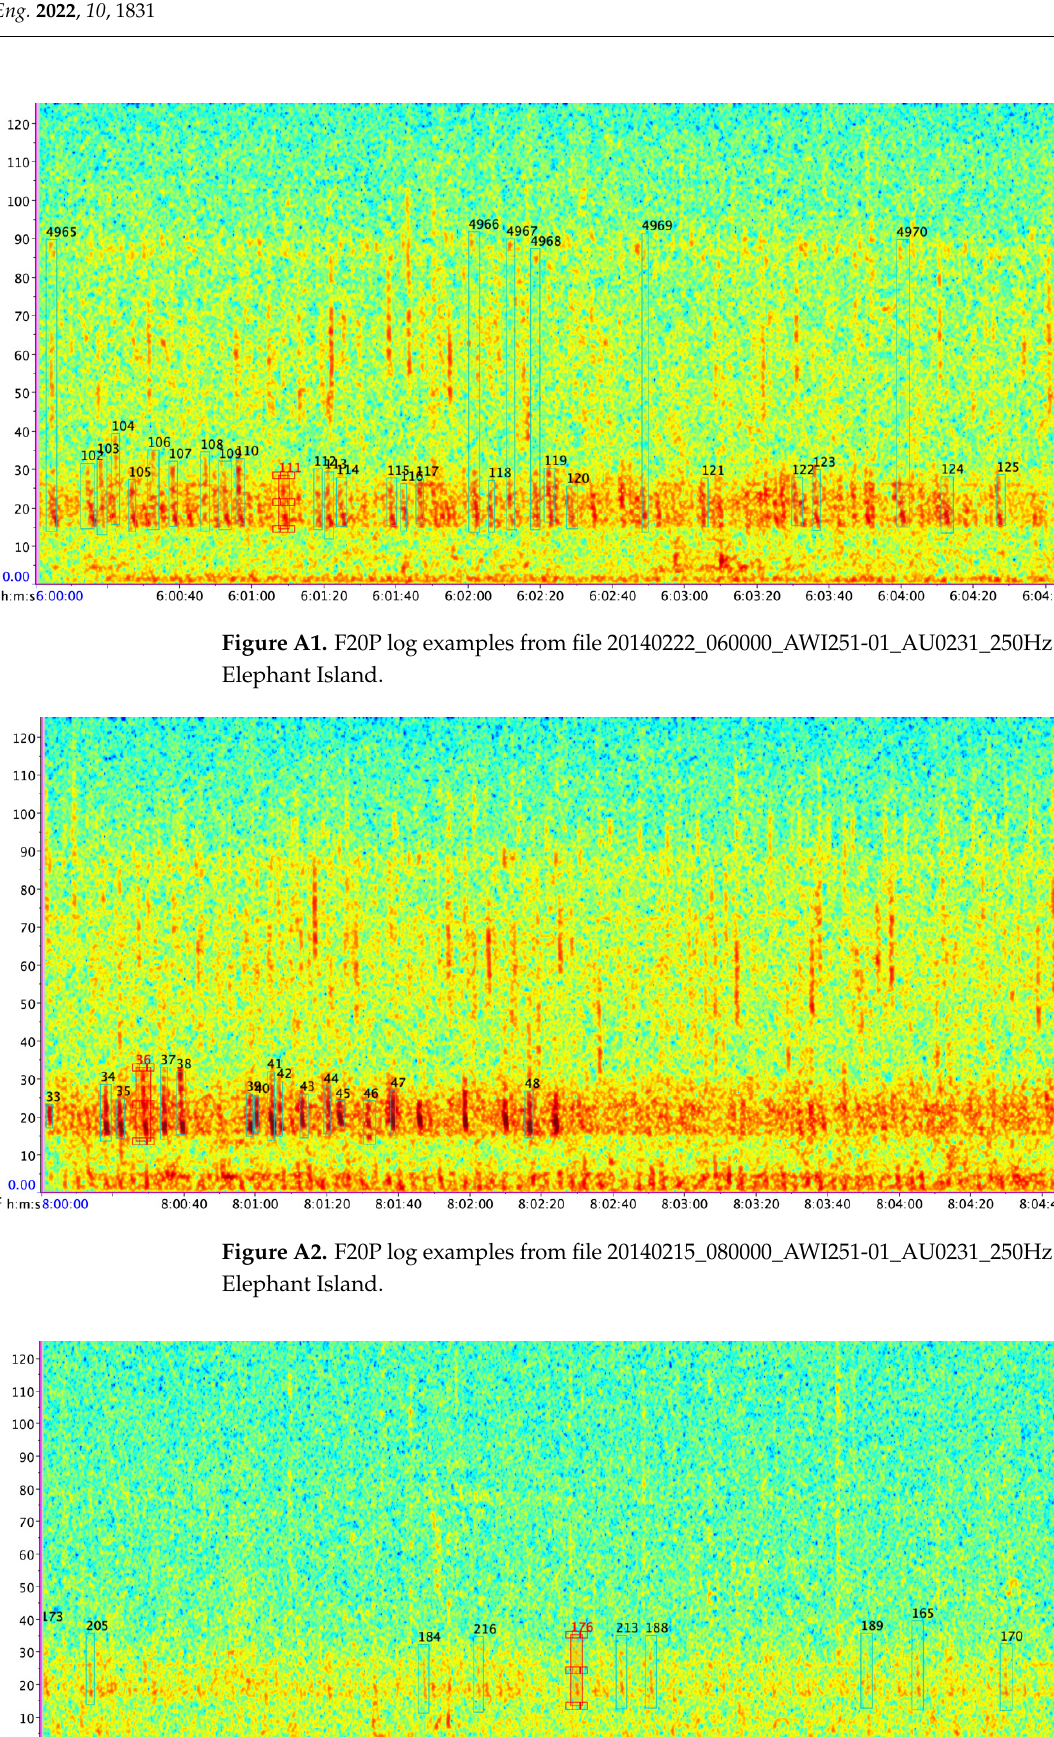
Figure A4. F20P log examples from file Balleny20150322_000000 for the location Balleny Island. Figure A5. F20P log examples from file 20170510_090000 for the location Casey.